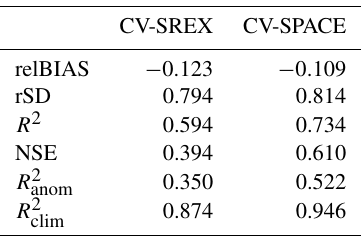
Table 1. Median values of skill scores for CV-SREX and CV-